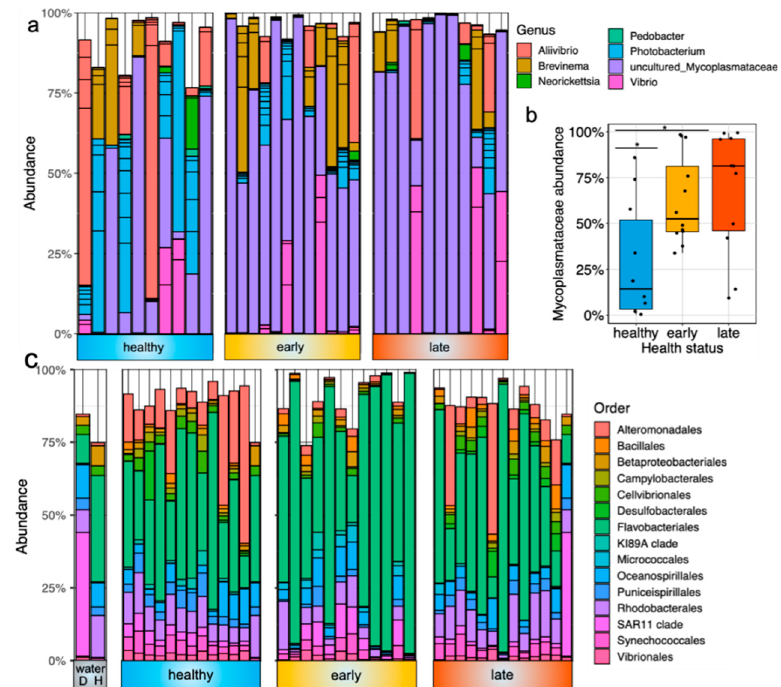
Figure 2. Taxonomic composition of the fish gut and skin microbiota with different health states: ( a ) barplot representing the relative abundance of the top 30 most abundant ASVs in the gut microbiota of fish exhibiting different health states (e.g., healthy, early stage of enteritis and late stage of enteritis); ( b ) boxplot representing the relative abundance of an uncultured Mycoplasmataceae sp. in the gut microbiota of fish exhibiting different health states; statistical differences were assessed using Wilcoxon test, with the levels of statistical significance between groups denoted by asterisks, with alpha set at 0.05; ( c ) barplot representing the relative abundance of the top 15 most abundant order in the skin microbiota of fish exhibiting different health status as well as seawater bacterial communities (D = diseased cage and H = healthy cage).